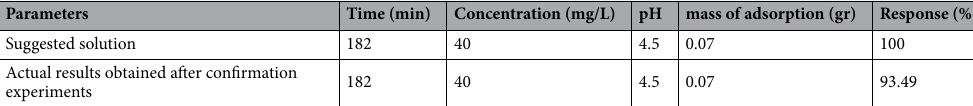
Table 7. Optimal cobalt adsorption conditions from the model.